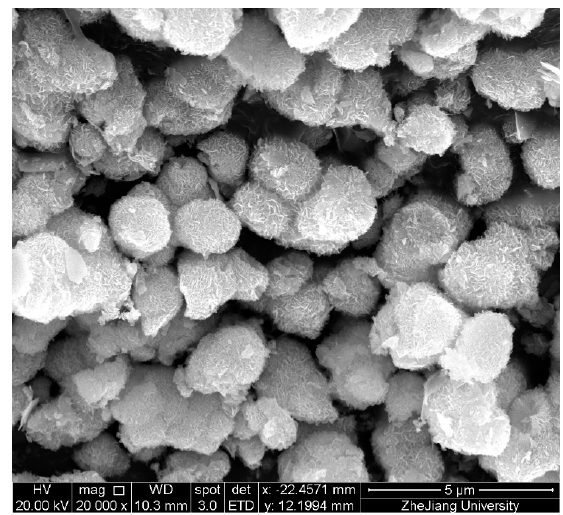
Figure 12. Scanning electron micrograph of prepared BiOI powder.